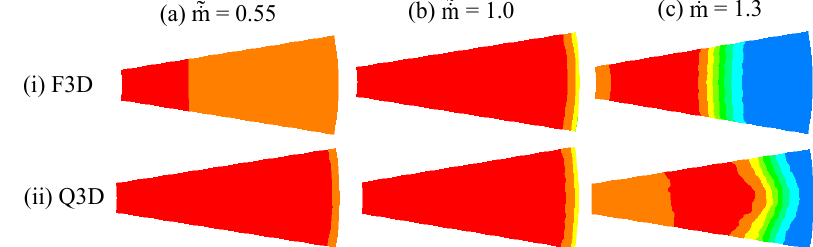
Figure 12. Comparison of stagnation pressure contours in a 20 ◦ sector at the fan